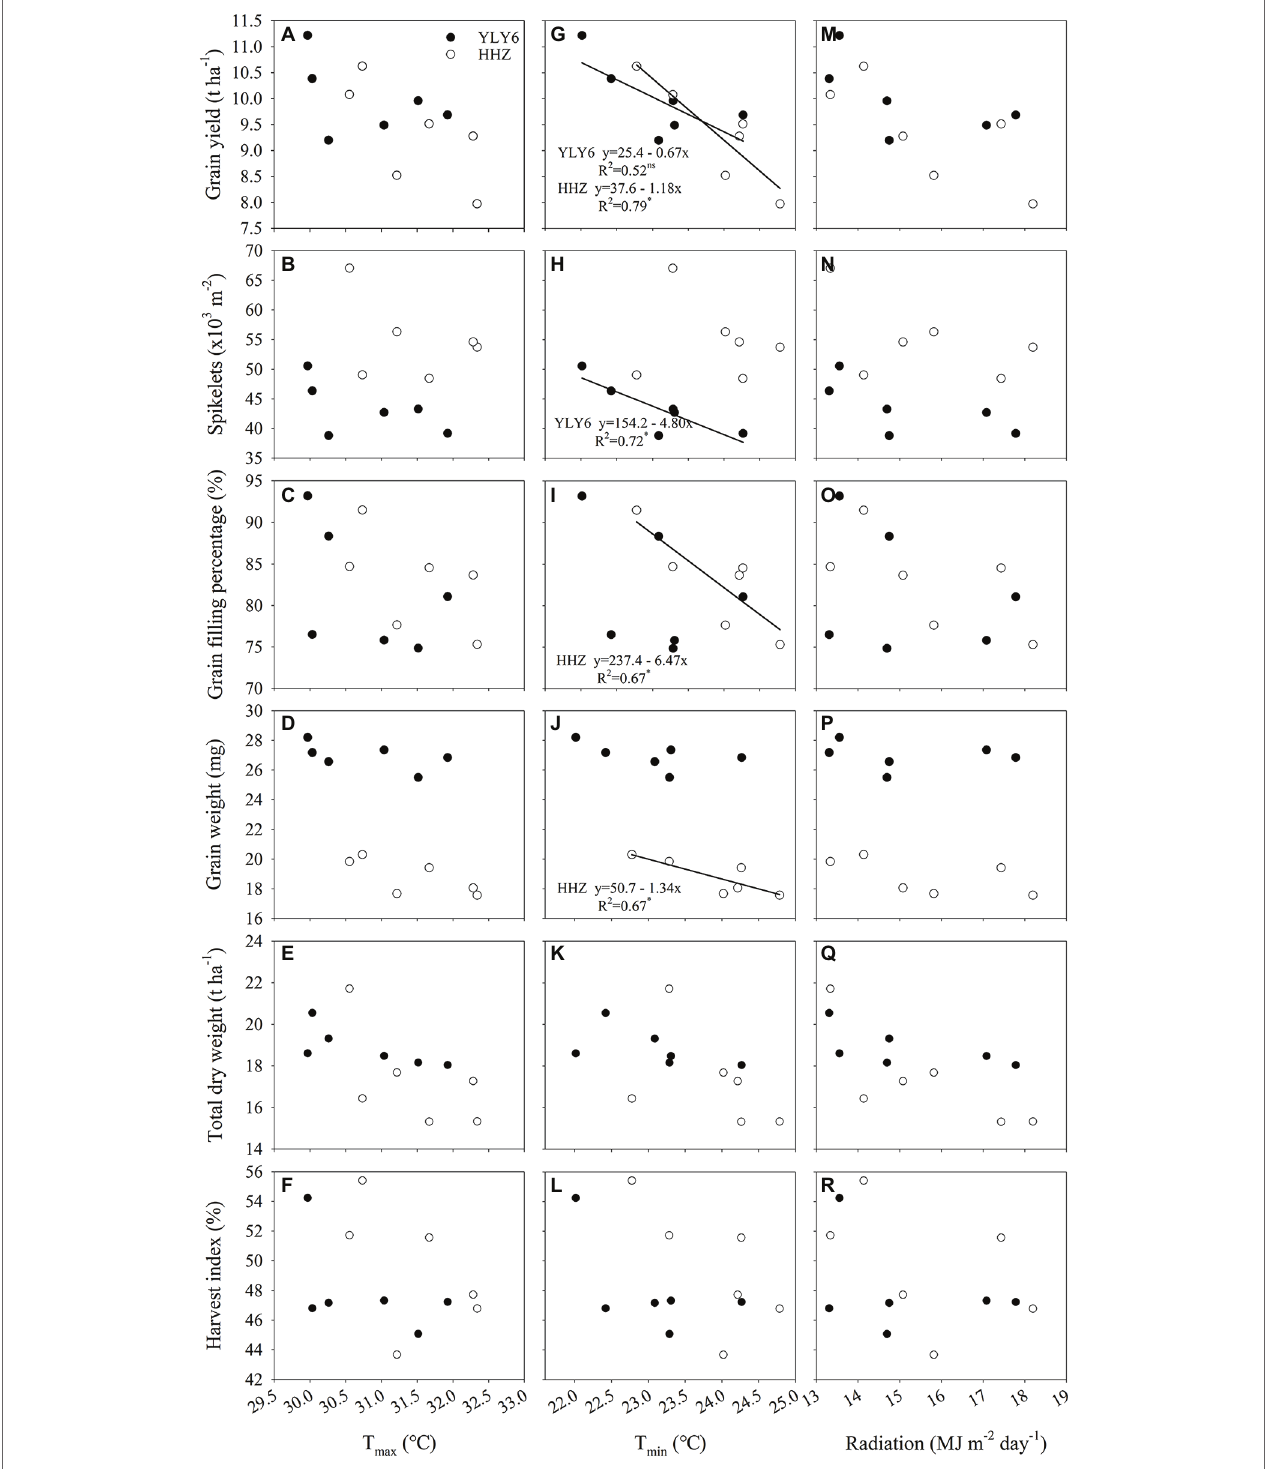
FIGURE 6 | The relationship between rice-yield attributes (grain yield, spikelets m − 2 , grain filling percentage, grain weight, total dry weight, and harvest) and growing-season mean maximum temperature (A–F) , minimum temperature (G–L) , and radiation (M–R) for YLY6 and HHZ. Growing-season mean maximum and minimum temperature and radiation were calculated from daily values for the entire season from transplanting to harvest. ns and ∗ are not statistically significant and significant at the p ≤ 0.05 probability level according to the Student’s t test, respectively. The regression equations are not shown in the graphs when the correlations are not significant. T max – the growing-season mean maximum temperature; T min – the growing-season mean minimum